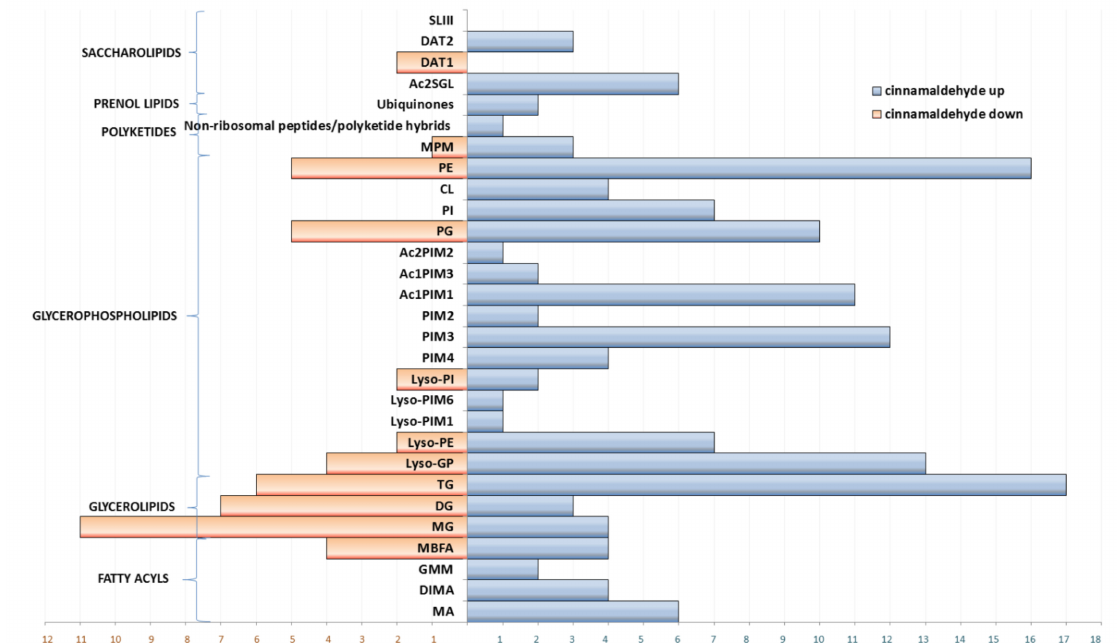
Figure3. Thenumberofdi ff erentm / zup-regulatedordown-regulatedundertheinfluenceofCA(versus untreated) assigned to a given lipid class. Blue and red bars represent up-regulated and down-regulated features, respectively. MA–Mycolic acids; DIMA–Phthiocerol dimycocerosates;